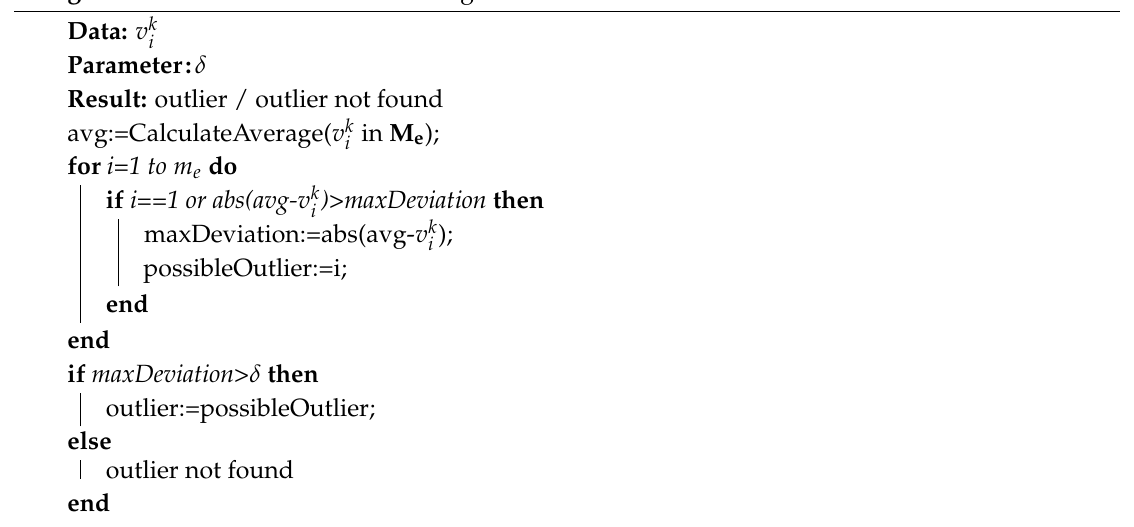
Algorithm 2: Used outlier detection